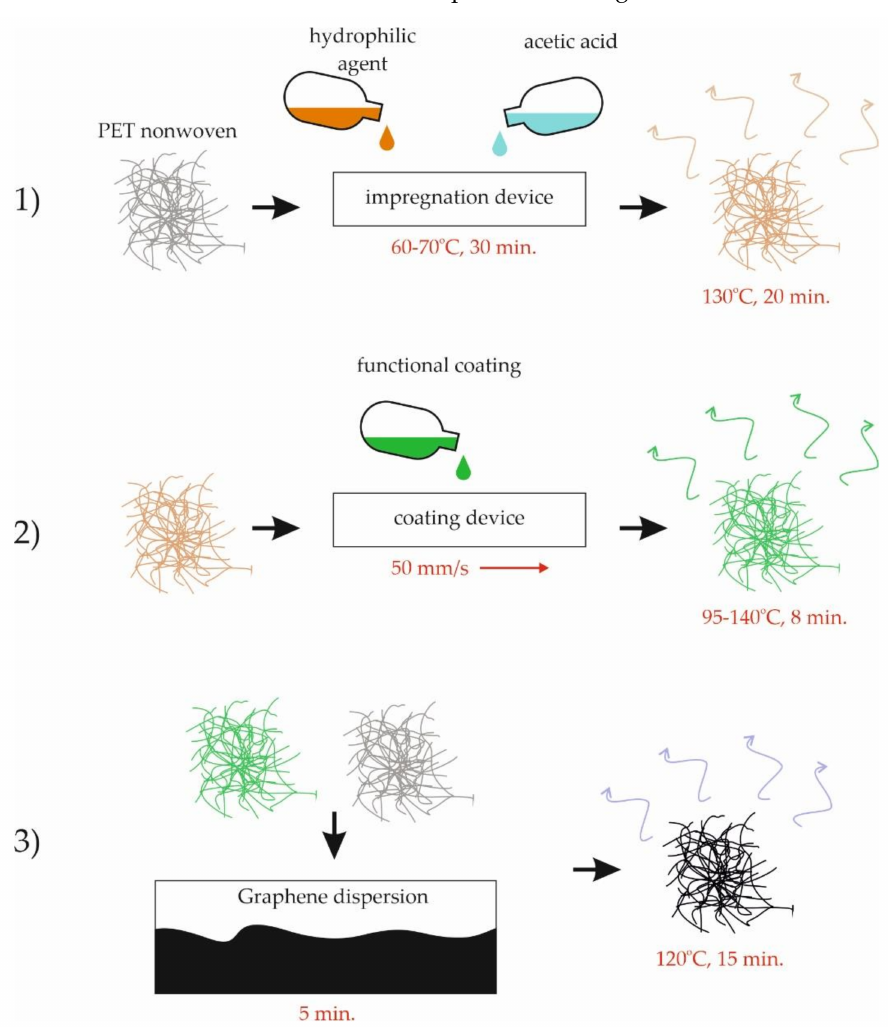
Figure 1. Flow chart of material’s fabrication in 3 steps: ( 1 ) treatment by hydrophilic agent and acetic acid, ( 2 ) treatment by functional coating, ( 3 ) treatment by graphene